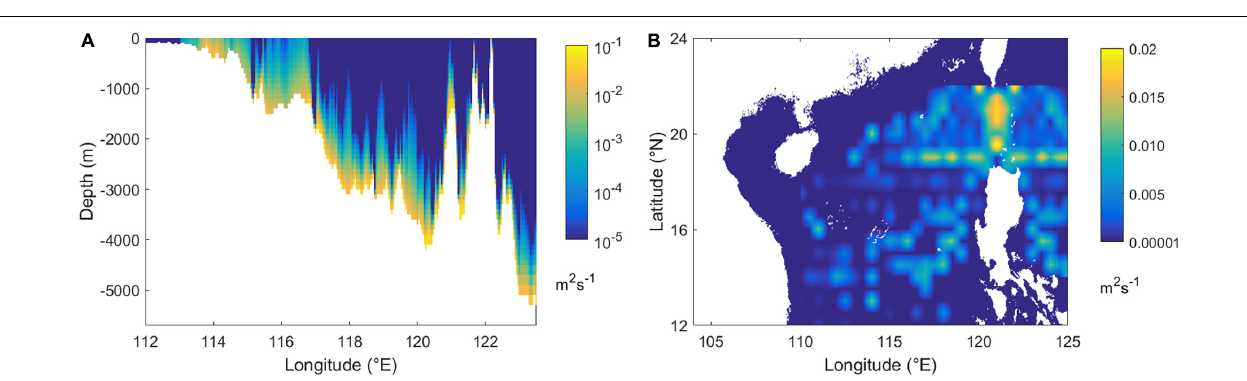
Frontiers in Marine Science |